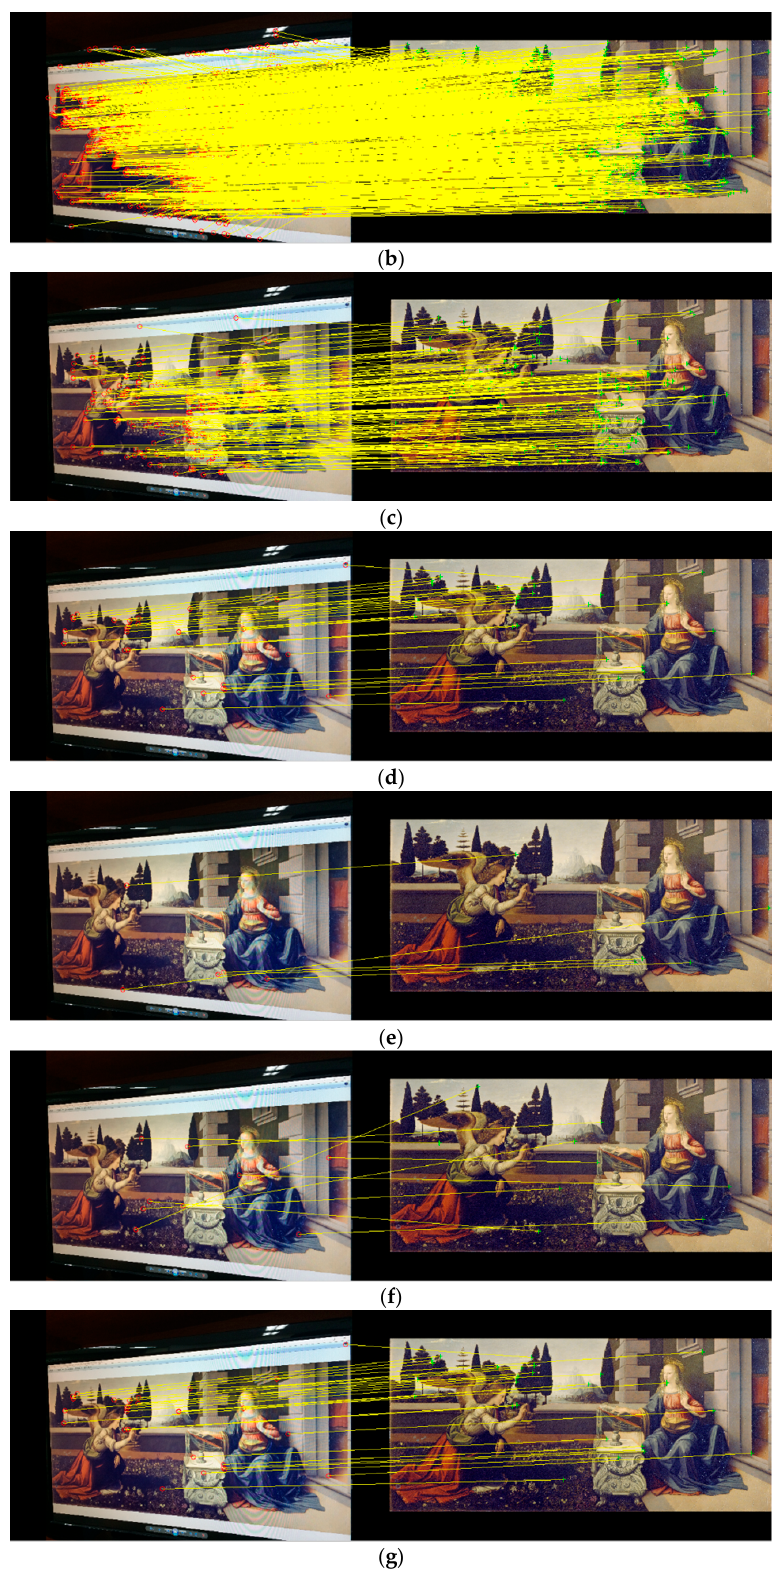
Figure 9. Matched keypoints for the seven types of features. ( a ) SIFT; (b) SURF; ( c ) MSER; ( d ) BRISK; ( e ) FAST; ( f ) HOG; ( g ) FREAK.